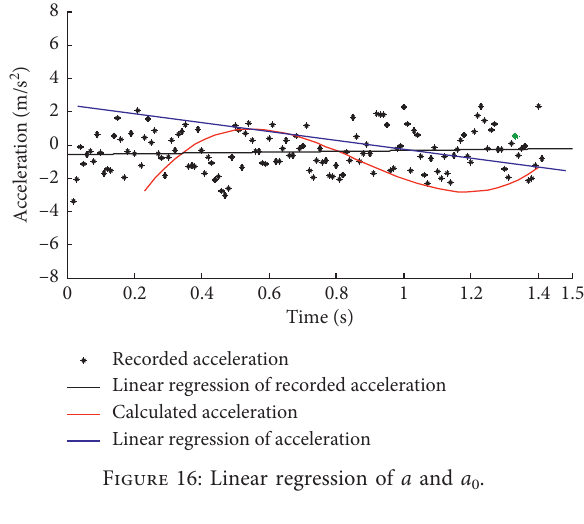
Figure 18: Compared analysis between v